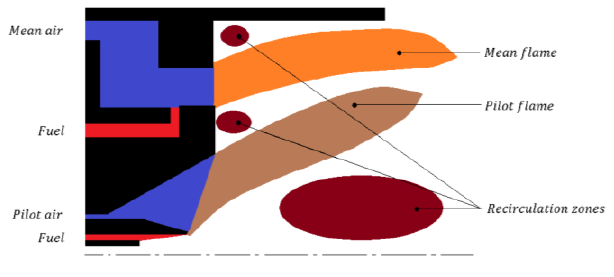
Fig. 3. LPP combustor scheme (basing on